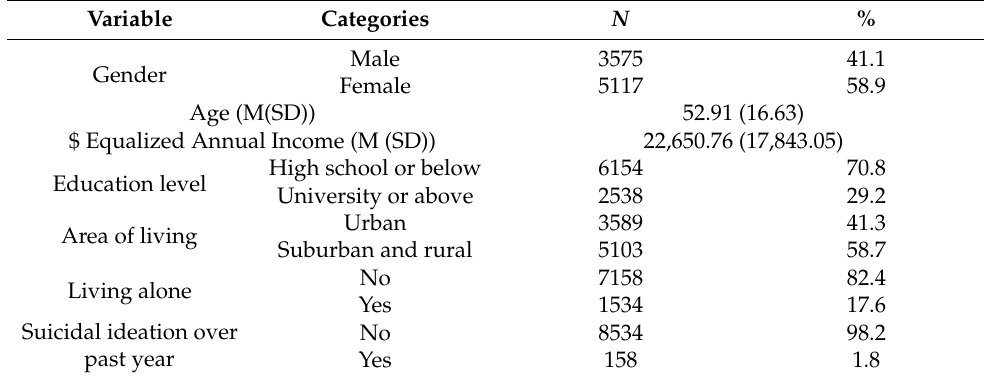
Table 1. Sociodemographic characteristics of the participants ( N = 8692).